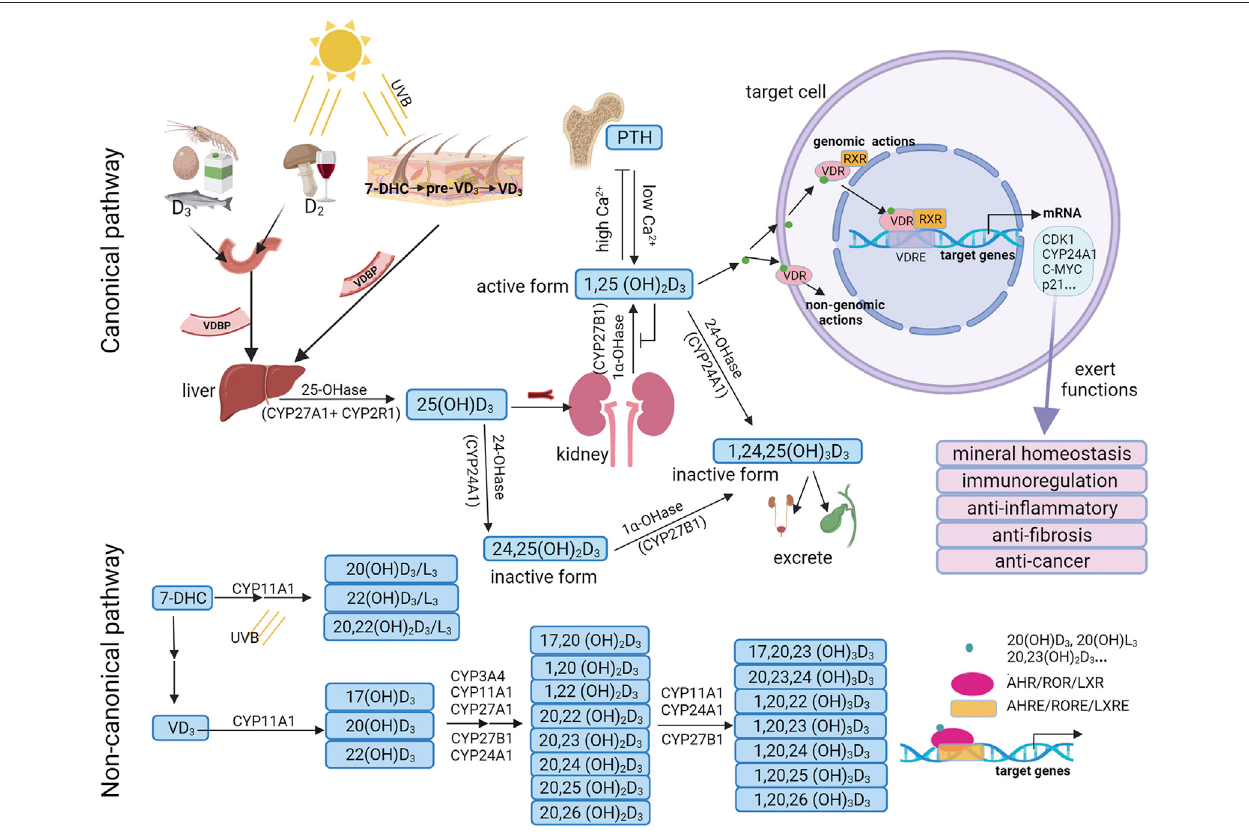
FIGURE 2 | Vitamin D 3 metabolism and biological functions. In the canonical pathway, vitamin D 3 can be hydroxylated by CYP27A1/CYP2R1 and CYP27B1 to form 25(OH)D 3 , and is then further hydroxylated tothe active form 1,25(OH) 2 D 3 . 1,25(OH) 2 D 3 can bind with VDR/RXR and translocate to the cell nucleus, where it binds to VDRE to regulate the transcription of target genes. Besides, 1,25(OH) 2 D 3 may bind with a membrane-associated receptor to mediate non-genomic actions. In the non-canonical pathway, 7-DHC and vitamin D 3 are fi rst hydroxylated by CYP11A1 and further hydroxylated by various cytochrome enzymes including CYP24A1, CYP27A1, CYP27B1, CYP2R1, CYP3A4, and CYP11A1 to form dihydroxy or trihydroxy metabolites. These bioactive metabolites selectively act on not only VDR, but alsoonalternativenuclearreceptorssuchasAHR,RORsorLXRsandbindstoAHREs,ROREsorLXREstoregulatethetranscriptionoftargetgenes.UVB,ultravioletB; 7DHC, 7-dehydrocholesterol; VDBP, vitamin D-binding protein; PTH, parathyroid hormone; VDR, vitamin D receptor; RXR, retinoid X receptor; VDREs, VDR response elements; CDK1, cyclin dependent kinase 1; AHR, aryl hydrocarbon receptor; RORs, retinoic acid orphan receptors; LXRs, liver X receptors; AHREs, AHR response elements; ROREs, ROR response elements; LXREs, LXR response